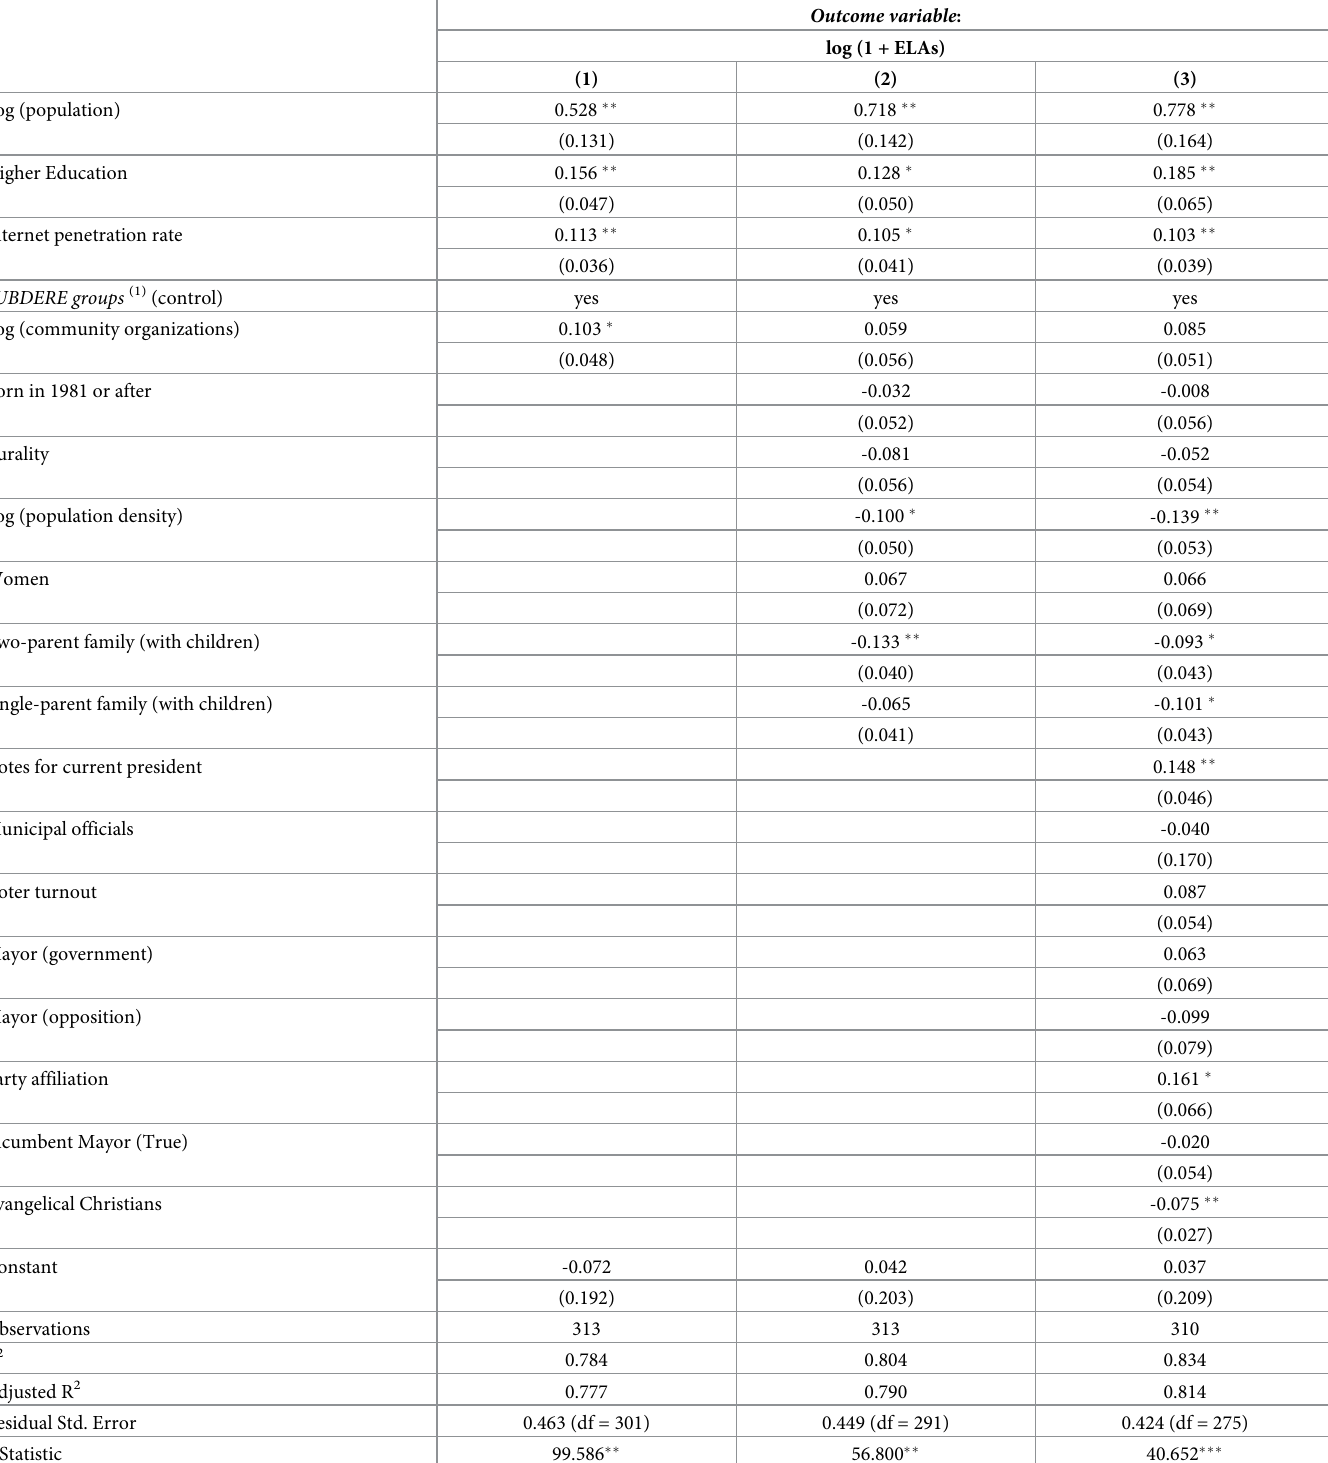
Table 2. OLS regressions. p-value RESET test Model 1 = 0.109, p-value RESET test Model 2 = 0.1418, p-value RESET test Model 3 = 0.3501. RESET test were performed on the second power of regressors.